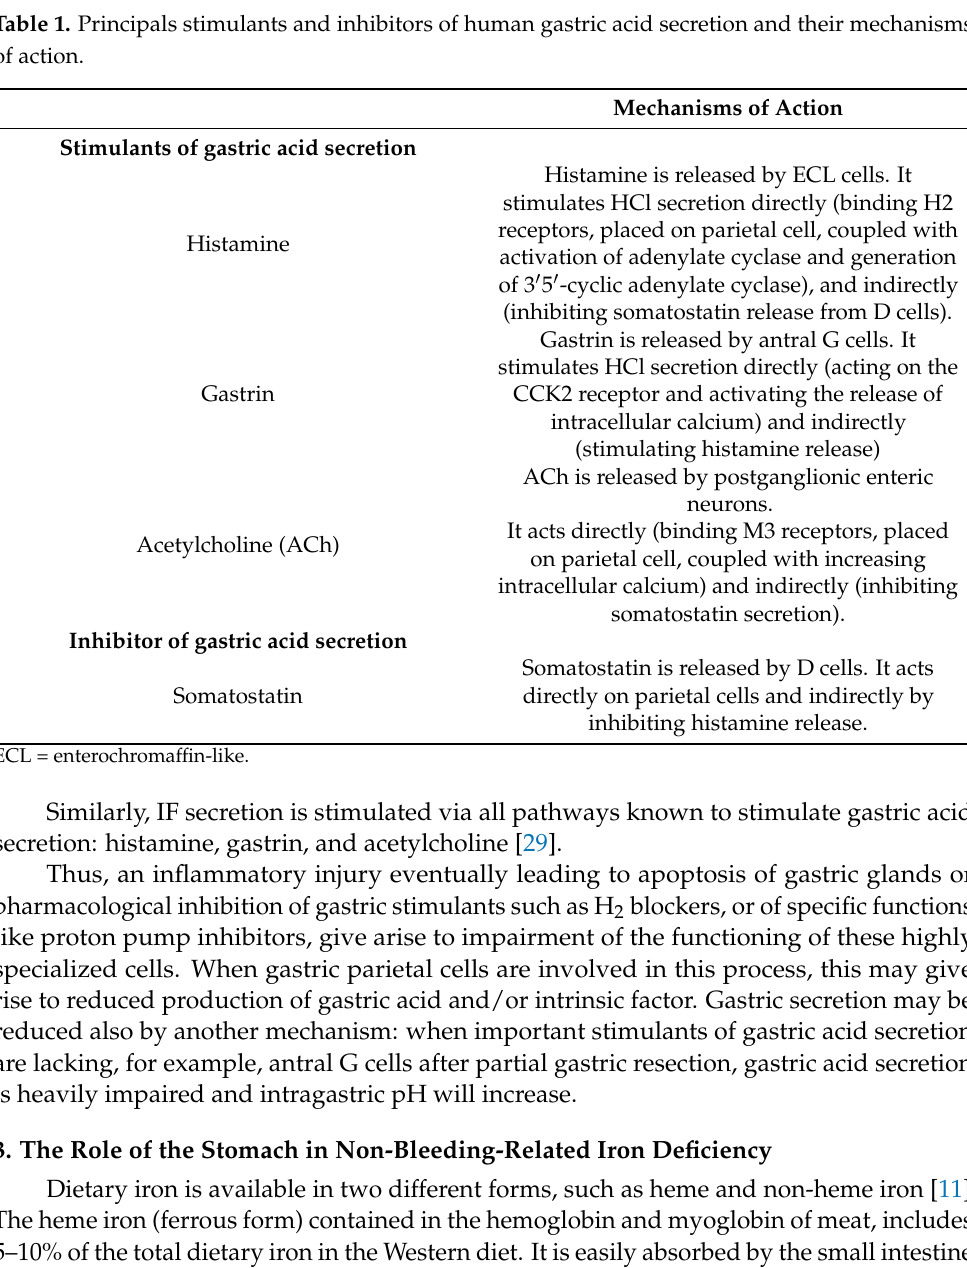
Table 1. Principals stimulants and inhibitors of human gastric acid secretion and their mechanisms of action. Stimulants of gastric acid